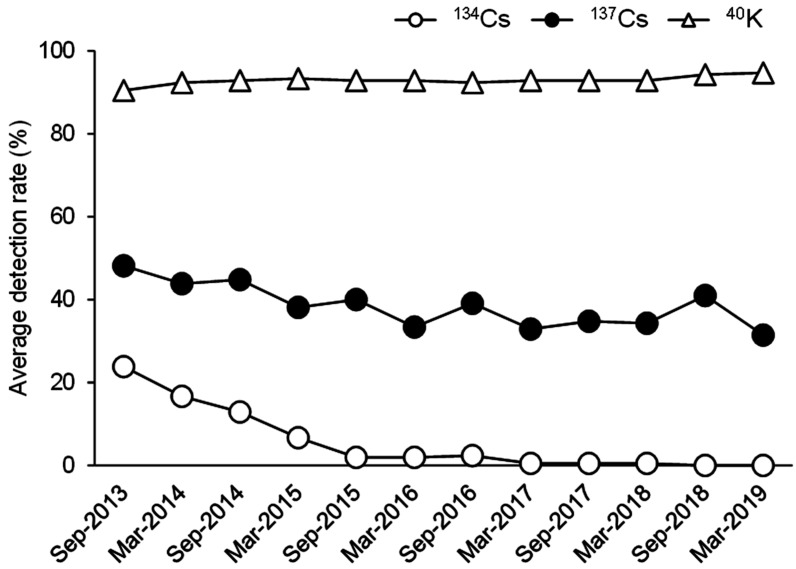
 Time trends of average detection rates for 134Cs, 137Cs, and
40K. Opened circles, filled circles, and opened triangles indicate
average detection rates for 134Cs, 137Cs, and 40K,
respectively.